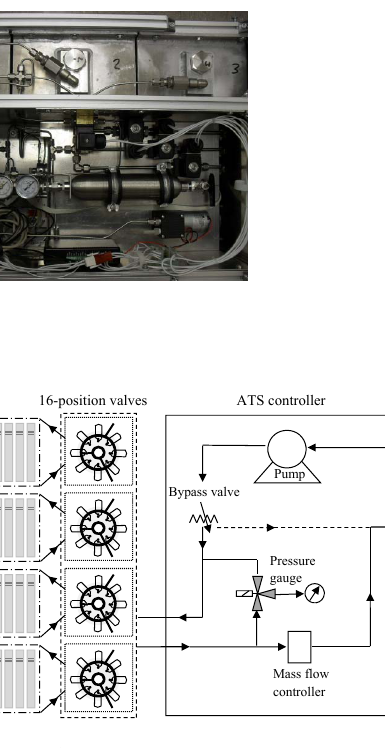
Figure 2. Schematic of the ATS. In standby or waiting mode, gas flow occurs through the dashed lines to the outlet. In sampling mode, gas flow is through the solid lines into the adsorption tubes.